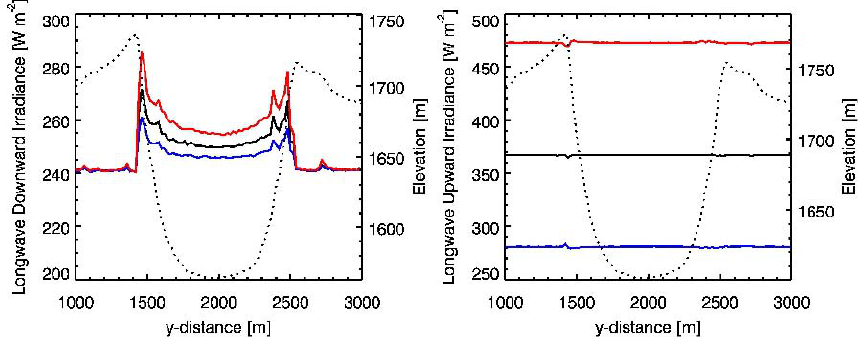
Fig. 11. Modeled longwave downward (left) and upward (right) irradiances at 2m above the topography under isothermal atmospheric stratification. Black: Surface temperature same as air temperature. Blue: Surface temperature 20 ◦ C colder than air temperature. Red: Surface temperature 20 ◦ C warmer than air temperature. Irradiances are represented by the scales on the left. Elevation cross sections are shown as thin dotted lines with the scale given on the right.